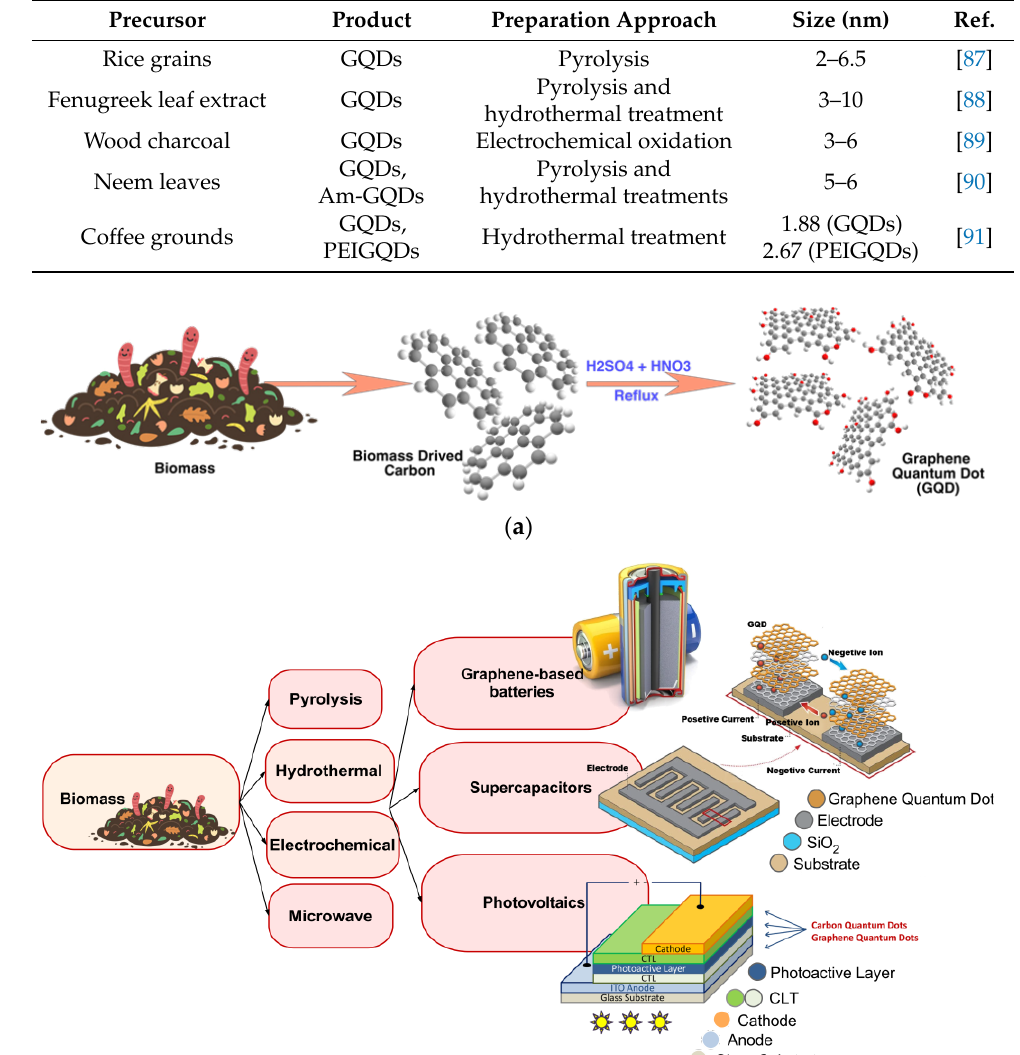
Table 2. Synthesis of GQDs from different types of biomass-waste.